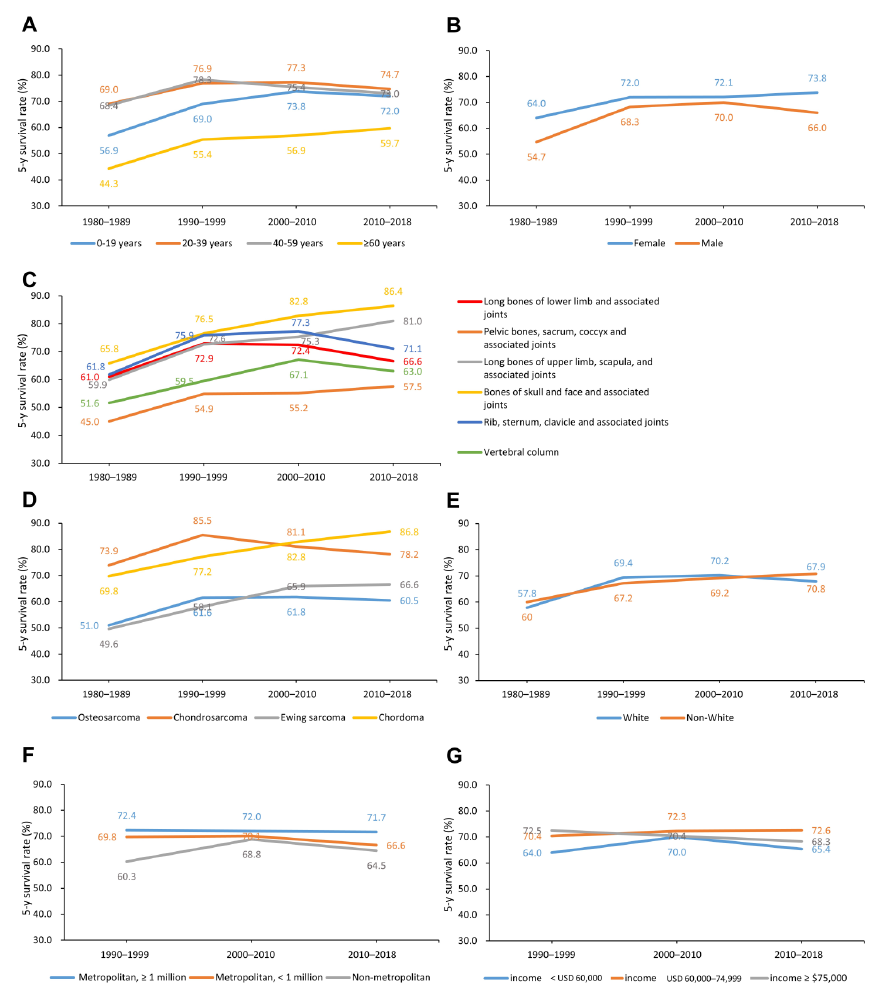
Figure 2. Time trends in 5-year CSS rates by decade in the categories by age ( A ), sex ( B ), primary site ( C ), histological type ( D ), racial ( E ), geographic ( F ), and economic ( G ). CSS: bone sarcomas- specific